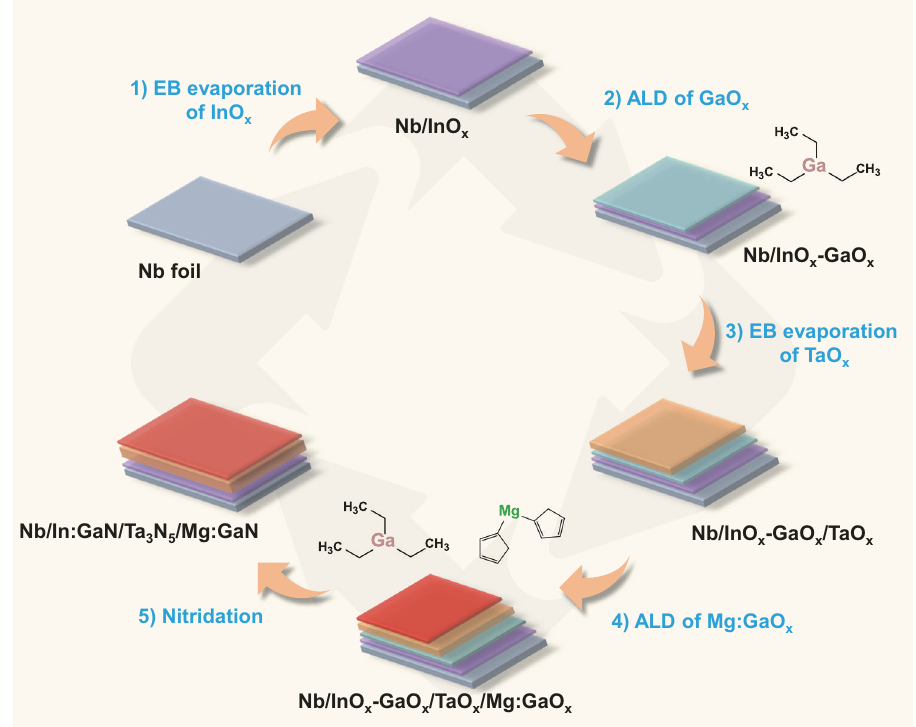
Fig. 1 Schematic diagram for the preparation of In:GaN/Ta 3 N 5 /Mg:GaN heterostructure thin fi lm. 1 EB evaporation of InO x thin layer on Nb substrate. 2 ALD of GaO x layer using TEG as precursor. 3 EB evaporation of TaO x layer. 4 ALD of Mg:GaO x layer using MgCp2 and TEG as precursors. 5 One-step thermal nitridation in NH 3 atmosphere at 1000 °C for 6 h.